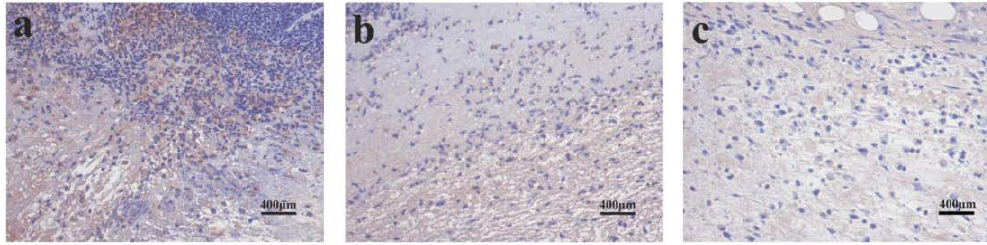
Figure 12. Immunohistochemistry of TNF- α (day 3) in ( a ) control, ( b ) PLA, and ( c ) PLA/PVA/SA groups.